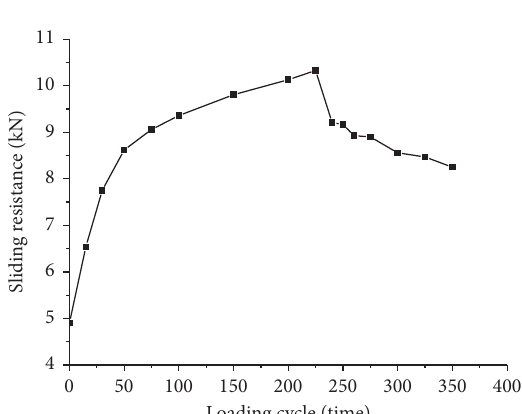
Figure 5: Test process picture.